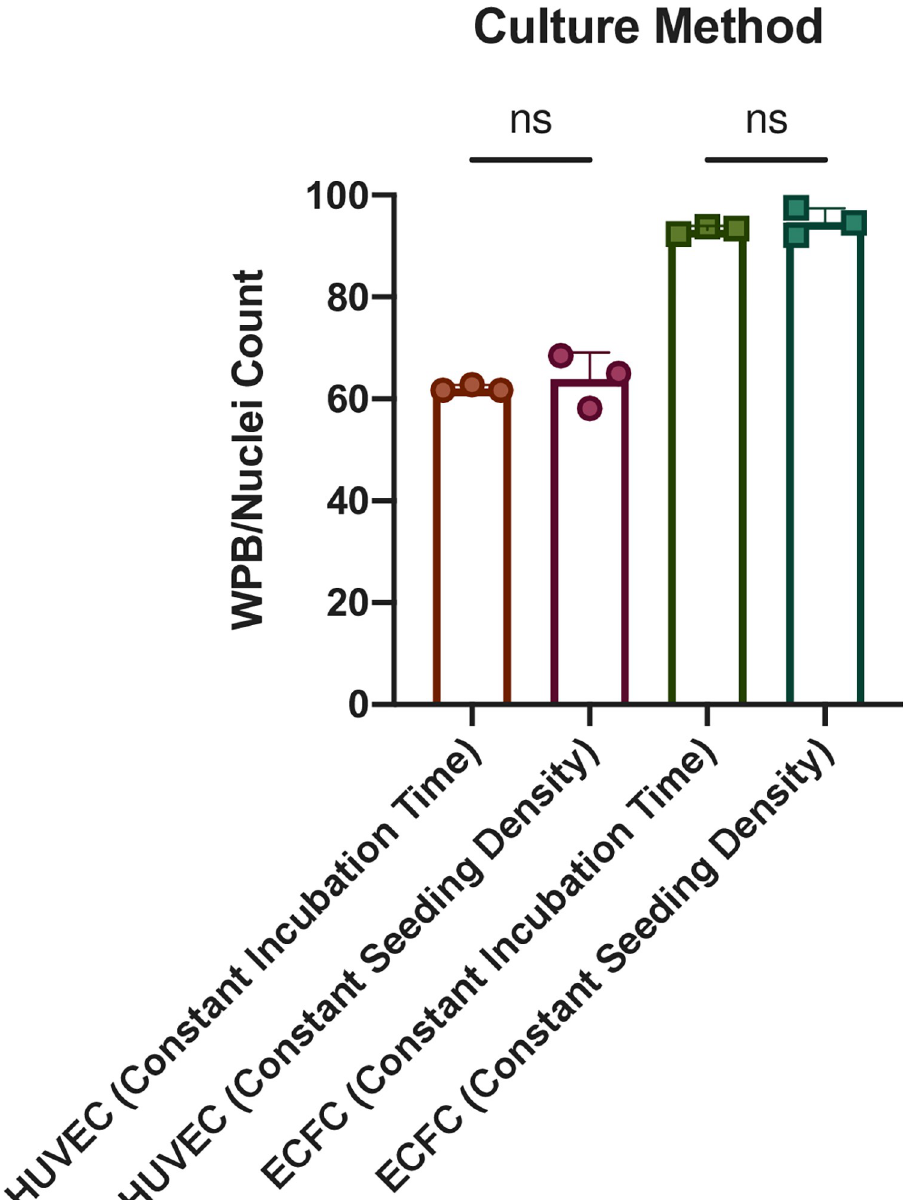
Fig 4. Comparison WPB/Nuclei count depending on culture method. WPB/nuclei count for constant incubation time (96 hrs.) and for constant seeding density (30,000 cells/cm 2 ) are shown. A 1-way ANOVA was performed to analyze the WPB/nuclei between constant incubation time and constant seeding density for HUVECs and ECFCs, ns p > 0.05 (n = 3). flow cytometer (Beckman-Coulter). ECFCs were positive for the endothelial markers PECAM (CD31), endoglin (CD105), and negative for leukocyte common antigen (CD45). CD34 exhib- ited mildly positive expression patterns constituent with other ECFC isolations [12, 18]. Colo- nies were expanded and aliquoted to be stored in liquid nitrogen. For each experiment, cells were maintained in EBM2-MV with FBS supplemented to 10% (Lonza). All endothelial cells used are passage < 5.